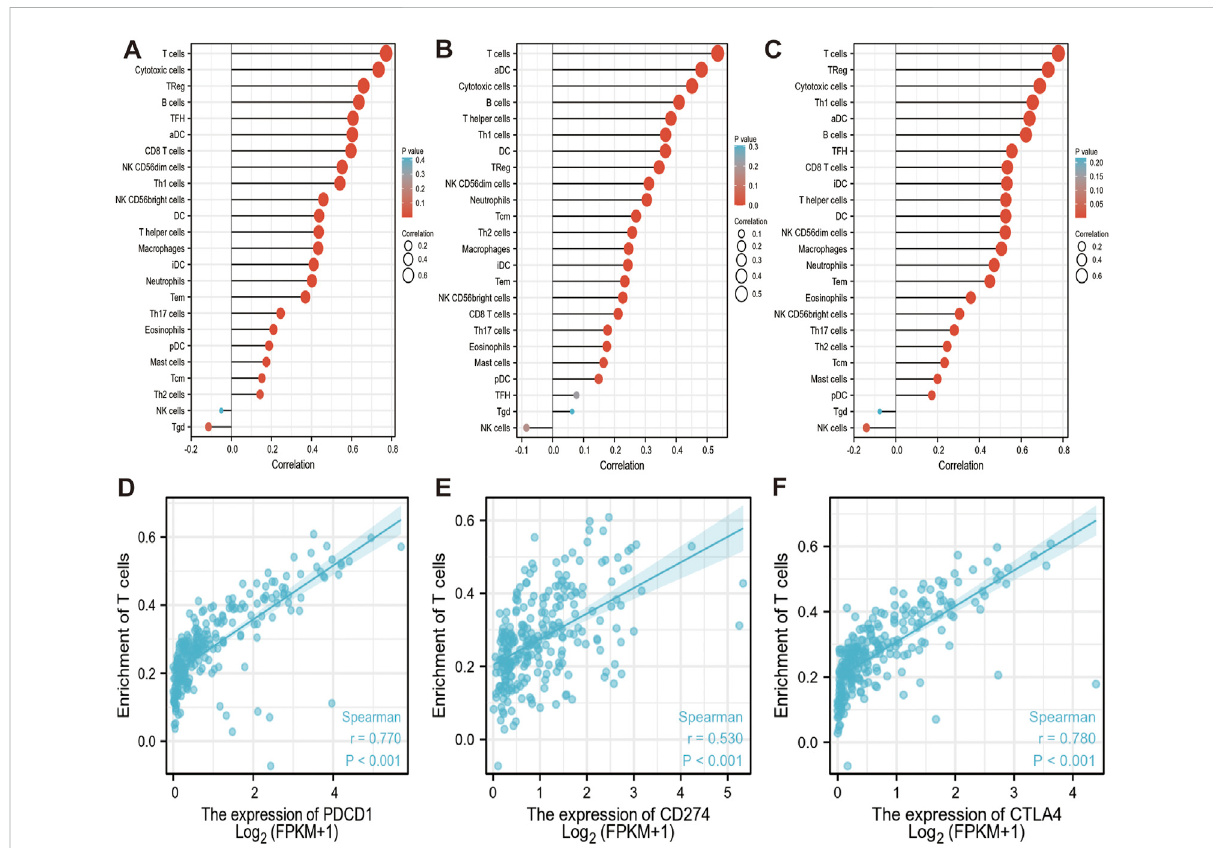
FIGURE 6 Correlation between PD-1/PD-L1/CTLA-4 expression andimmunein fi ltrationin SARC. (A,B,C) Correlation between theexpressionofPD-1 (A) , PD-L1 (B) andCTLA-4 (C) andtheabundanceof24tumor-in fi ltratinglymphocytesinSARC, computedusingGSVA(https://www.bioconductor.org/ packages/3.4/bioc/htmL/GSVA.html). Red circles represent positive correlations (Spearman_Cor > 0). The size of circles is proportional to the spearman ’ s correlation co-ef fi cient in immune cells. (D,E,F) Spearman correlation plots between log 2 PD-1 (D) , PD-L1 (E) , CTLA-4 (F) genes expression values and enrichment T cells are shown in SARC. Spearman correlation between the two measurements was positive signi fi cant (r > 0, p < 0.001). The blue lines represent the best- fi t linear model, and the gray lines represent the 95% con fi dence interval, calculated using ggplot2 (https://cran.rproject.org/web/packages/ggplot2/index.html). aDC: active dendritic cells; B cells: B lymphocytes; CD8 T cells: Cytotoxic T lymphocytes; DC: dendritic cells; iDC: immature dendritic cells; NK CD56bright cells: natural killer CD56bright; NK CD56dim cells: natural killer CD56dim cells; pDC: Plasmacytoid dendritic cells; T cells: T lymphocyte; Tcm: T central memory; Tem: T effector memory; Tfh: T follicular helper; Th1 cells: T helper type 1 cells; Th17 cells: T helper 17 cells; Th2 cells: T Helper 2 Cells; Treg: Regulatory T